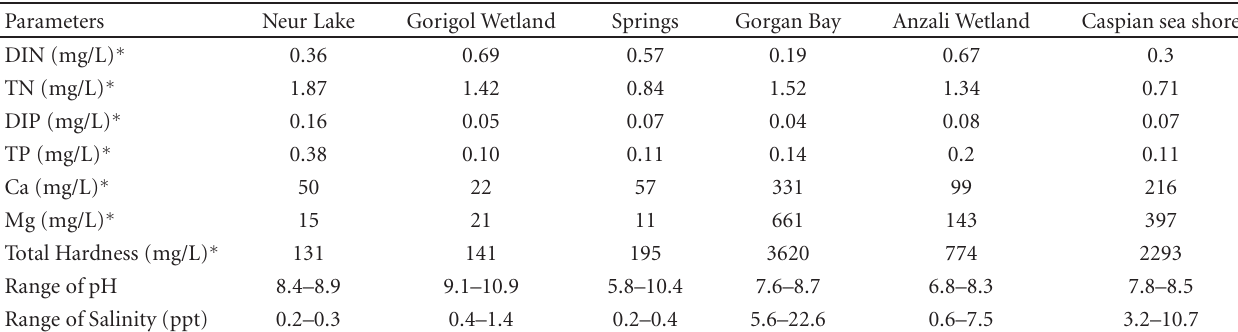
Table 4: Some abiotic characteristics of the